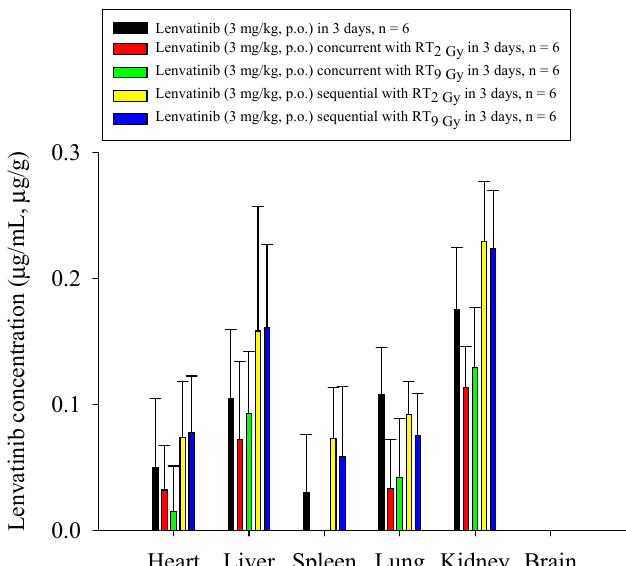
Figure 5. The concentration of lenvatinib in the heart, liver, spleen, lung, kidney, and brain of rats after the administration of lenvatinib (3 mg/kg, p.o.) with or without radiotherapy. The lenvatinib concentrations in the organs are expressed in units of μ g/mL or μ g/g ( n = 6 per group).